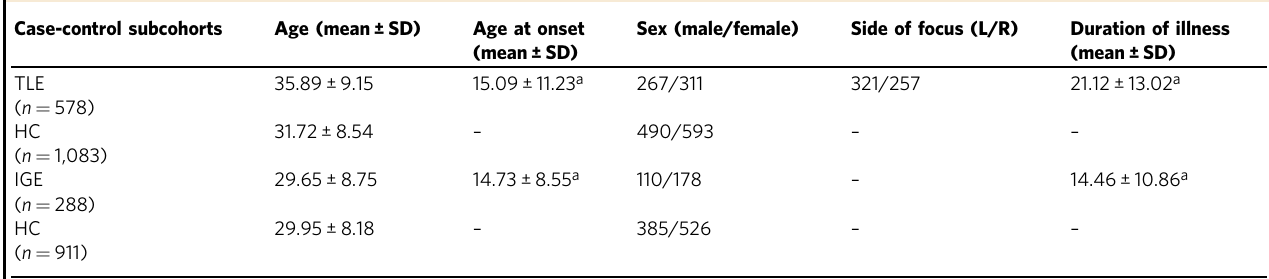
Demographic breakdown of patient-speci fi c subcohorts with site-matched controls, including age (in years), age at onset of epilepsy (in years), sex, side of seizure focus (TLE patients only), and mean duration of illness (in years). Healthy controls from sites that did not have TLE (or IGE) patients were excluded from analyses comparing TLE (or IGE) to controls. a Information available in 544/578 TLE patients and 248/288 IGE